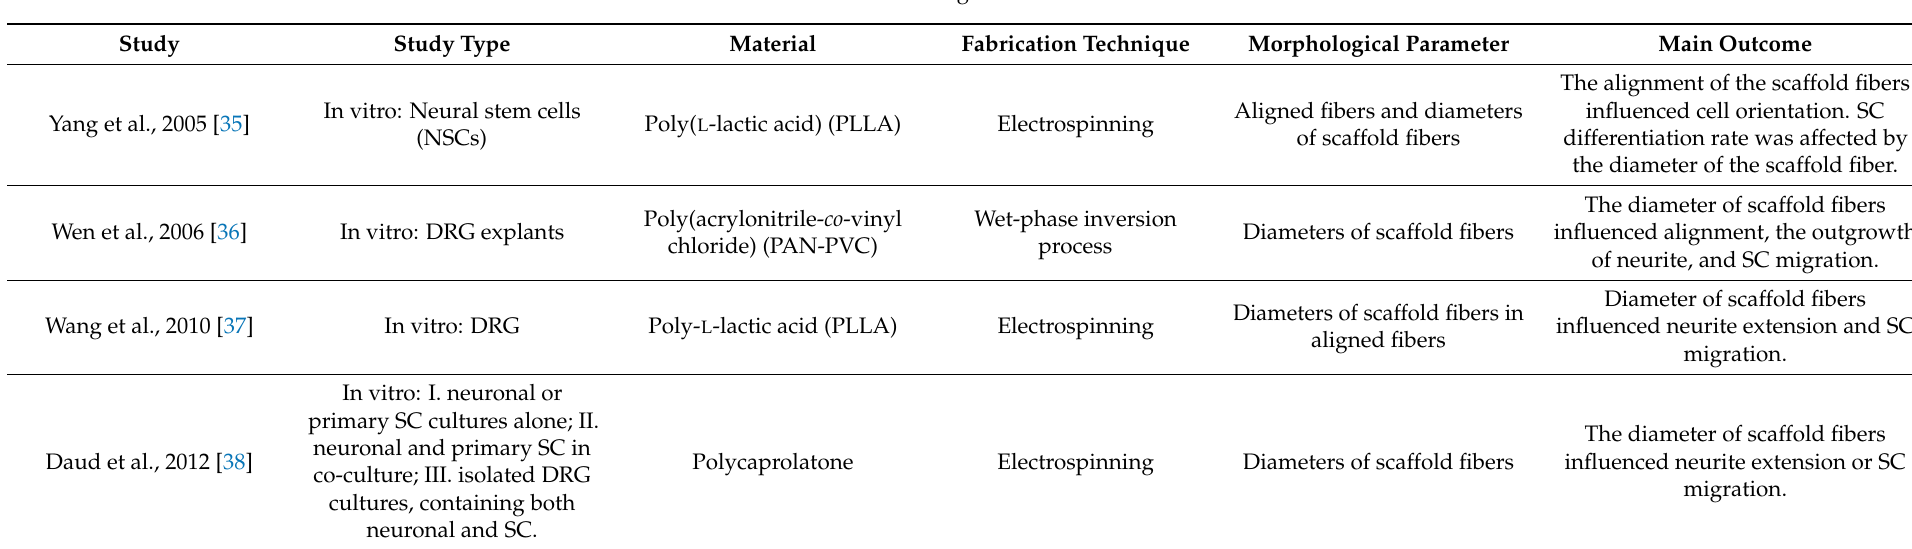
Table 4. Studies evaluating diameter of fibers of